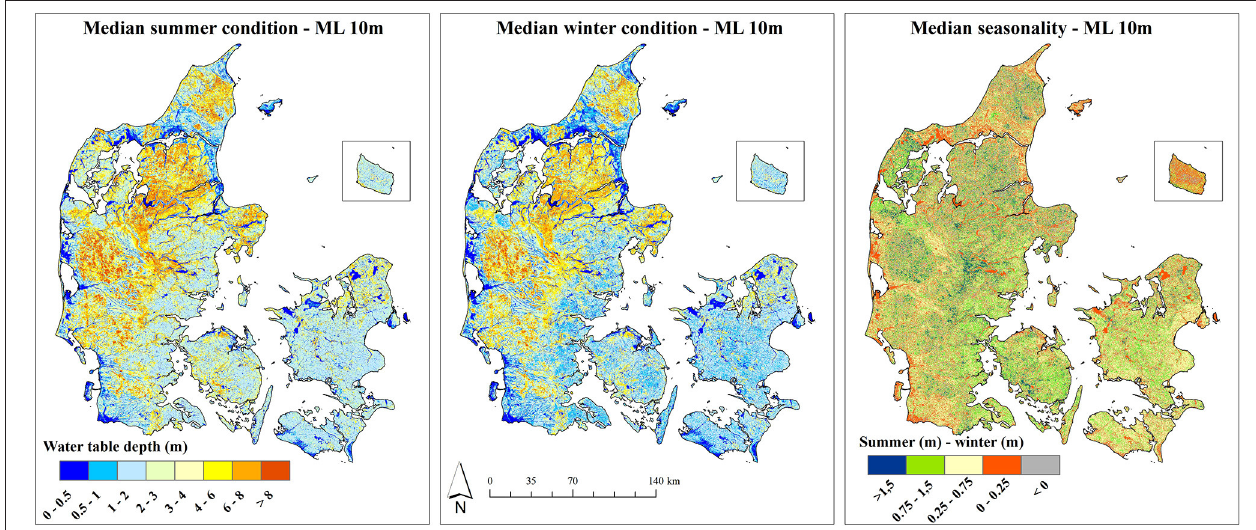
FIGURE 4 | Simulation results for the depth of the uppermost water table obtained from the summer and winter model at 10m spatial resolution, left and center panel, respectively. The right panel depicts the simulated amplitude calculated as summer depth minus winter depth.